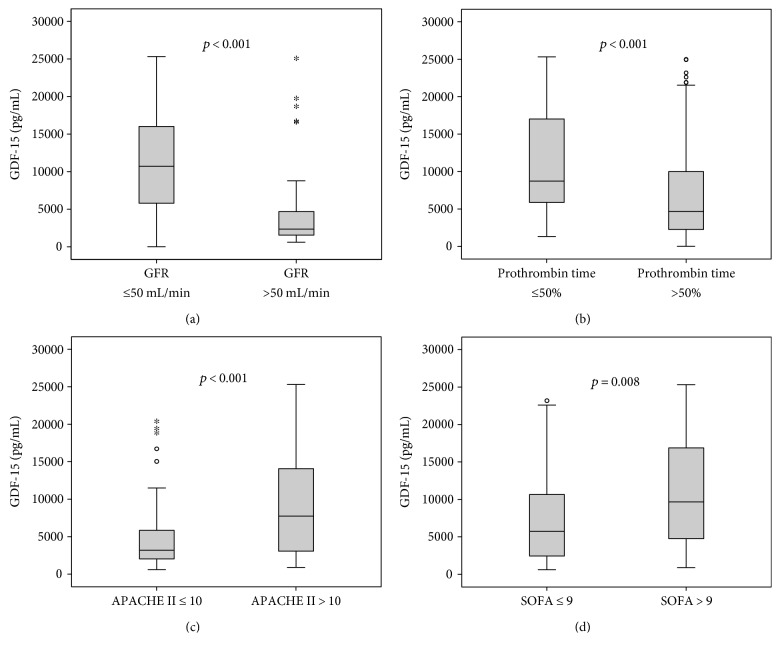
Serum GDF-15 levels in critically ill patients are associated with organ failure and disease severity. Serum levels of GDF-15 at the time of admission to the ICU were significantly higher in critically ill patients with renal failure (cystatin C-based glomerular filtration rate (GFR) < 50 mL/min (a)); asterisks denote significance values at) and hepatic failure (prothrombin time < 50% (b)). Critically ill patients with higher disease severity as represented by clinical scores (APACHE II (c) and SOFA (d)) showed significantly higher GDF-15 levels.